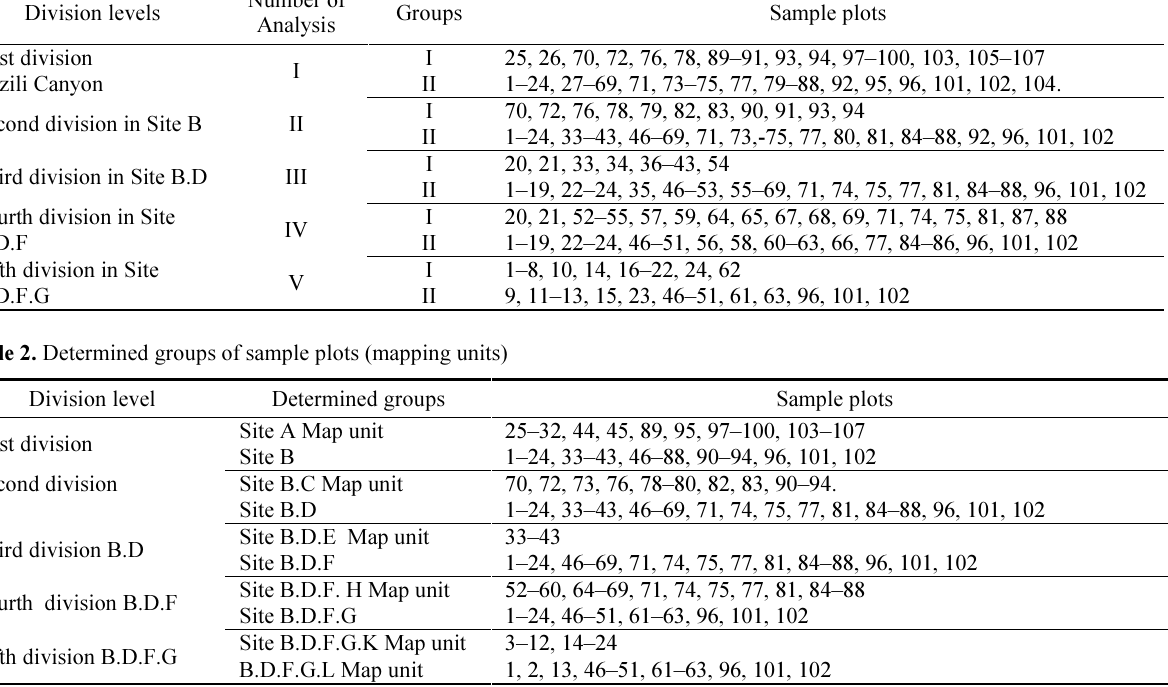
Table 1. Outputs of TWINSPAN Division levels